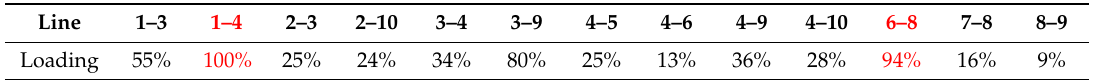
Table 4. Line loading